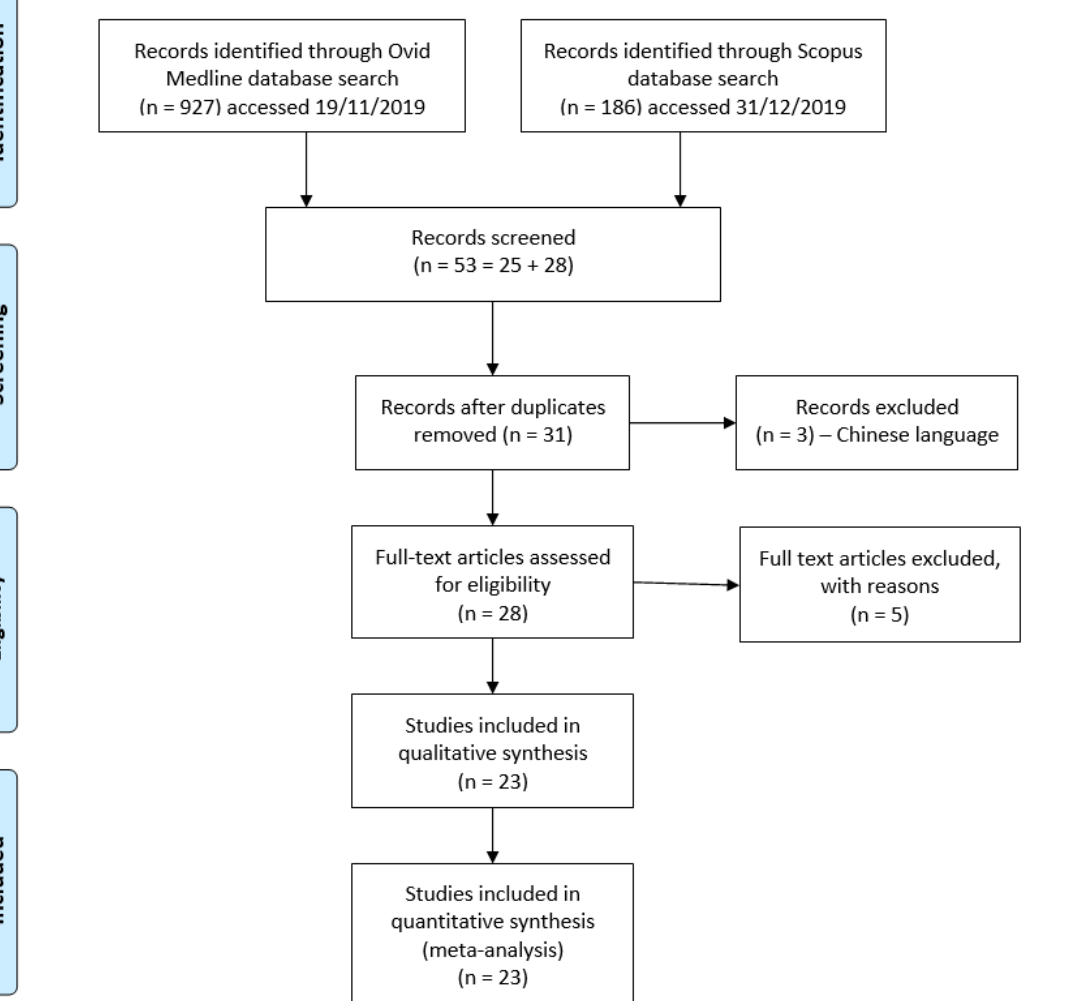
Figure 2. Flowchart for identification of relevant studies for a systematic review.